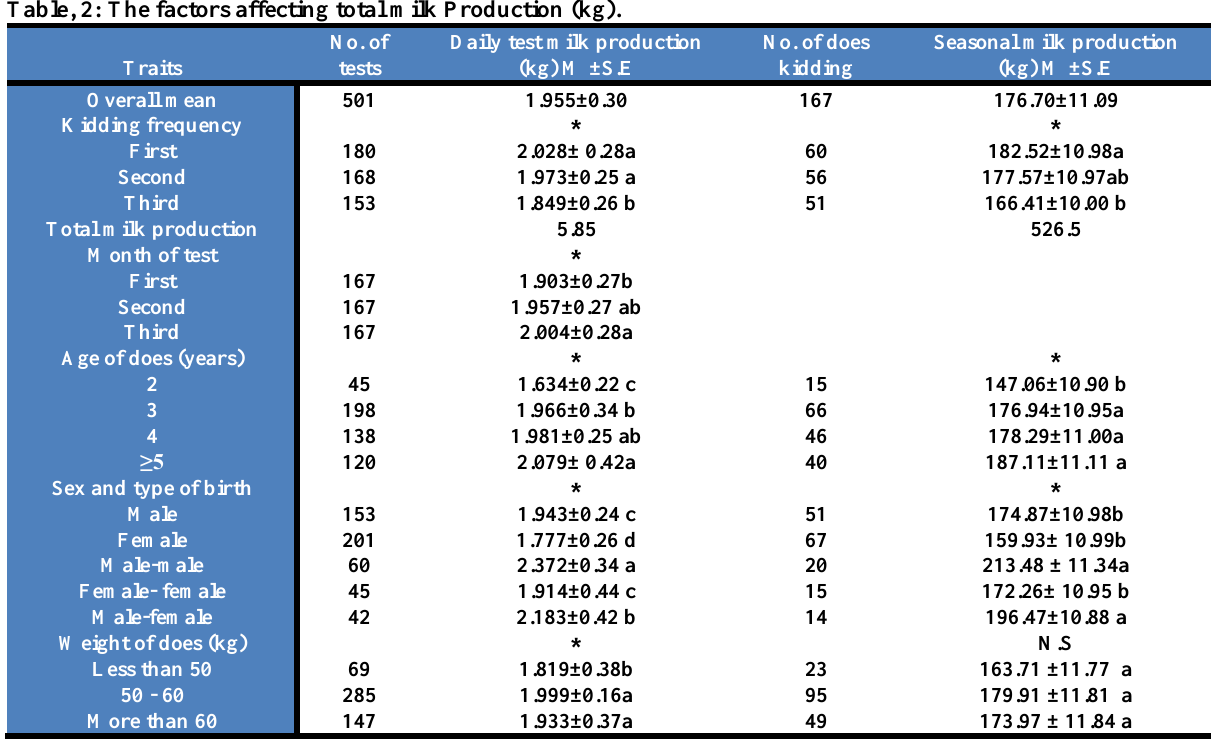
No. of Daily test milk production tests